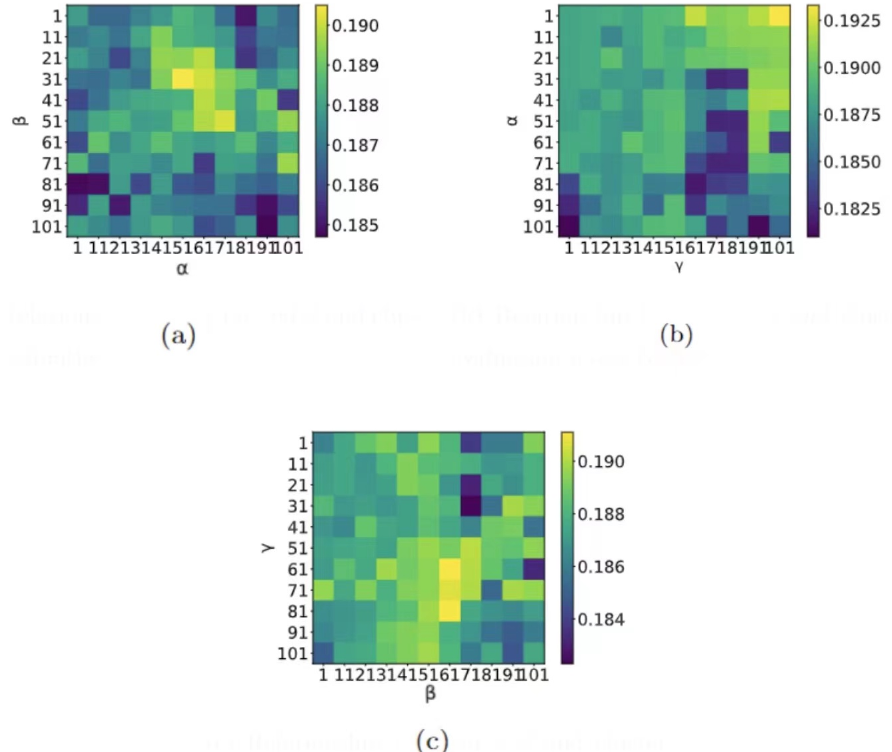
Figure 3. Relationship between α , γ , β and cluster evaluation index NMI. ( a ) Relationship between α , β and cluster evaluation index NMI; ( b ) Relationship between α , γ and cluster evaluation index NMI; ( c ) Relationship between γ , β and cluster evaluation index